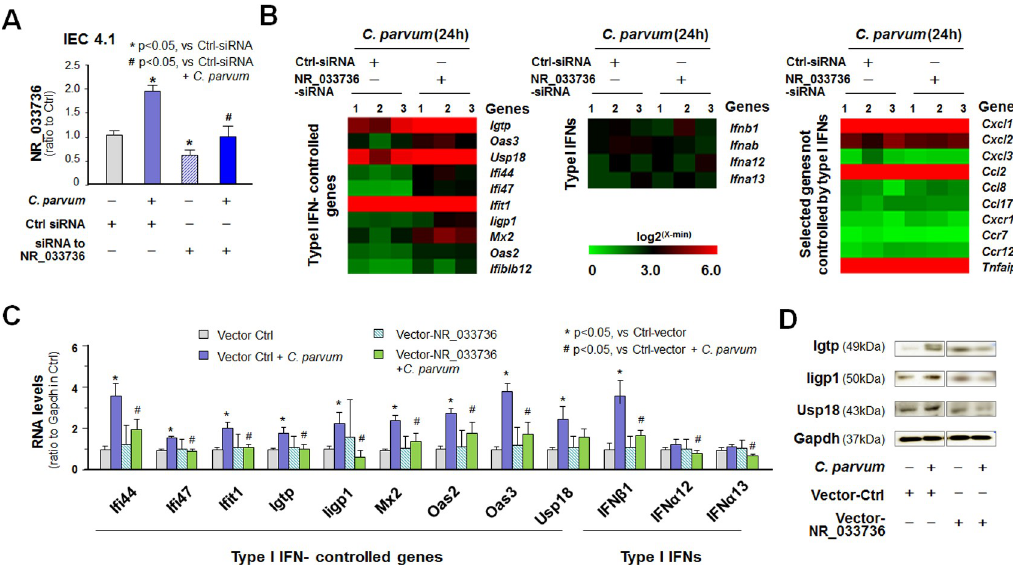
Fig 3. NR_033736 modulates type I IFN-controlled gene transcription in intestinal epithelial cells in response to C . parvum infection. (A) Knockdown of NR_033736 expression with the siRNA in IEC4.1 cells in response to C . parvum infection. Cells were treated with the siRNA to NR_033736 for 24 h and then exposed to C . parvum infection for 8 h. Expression level of NR_033736 was validated by using qRT-PCR. A non-specific scrambled siRNA was used as the siRNA control (Ctrl-siRNA). (B) Heatmaps representing upregulation of the top 10 type I IFN-controlled genes, as well as selected type I IFN genes and inflammatory genes not directly regulated by type I IFNs, in IEC4.1 cells treated with Ctrl-siRNA or siRNA-NR_033736 following C . parvum infection. IEC4.1 cells were treated with the Ctrl-siRNA or siRNA-NR_033736 for 24 h and then exposed to C . parvum infection for 24 h followed by genome-wide array analysis. (C) Overexpressing NR_033736 attenuated the expression of type I IFN-controlled genes in IEC4.1 cells following C . parvum infection. Cells were transfected with either the control vector (Ctrl-vector) or vector-NR_033736 for 24 h and then exposed to C . parvum infection for 24 h. Expression levels of type I IFN- controlled genes and selected type I IFN genes were measured. Data represent three independent experiments. (D) Effects of overexpressing NR_033736 on the expression of selected type I IFN-controlled genes, Igtp , Iigp1 , and Usp18 , at their protein levels in IEC4.1 cells following C . parvum infection. Cells were transfected with either the control vector (Ctrl-vector) or vector- NR_033736 for 24 h and then exposed to C . parvum infection for 24 h, followed by Western blot analysis. Gapdh was also blotted for control and representative blotting gels are shown.